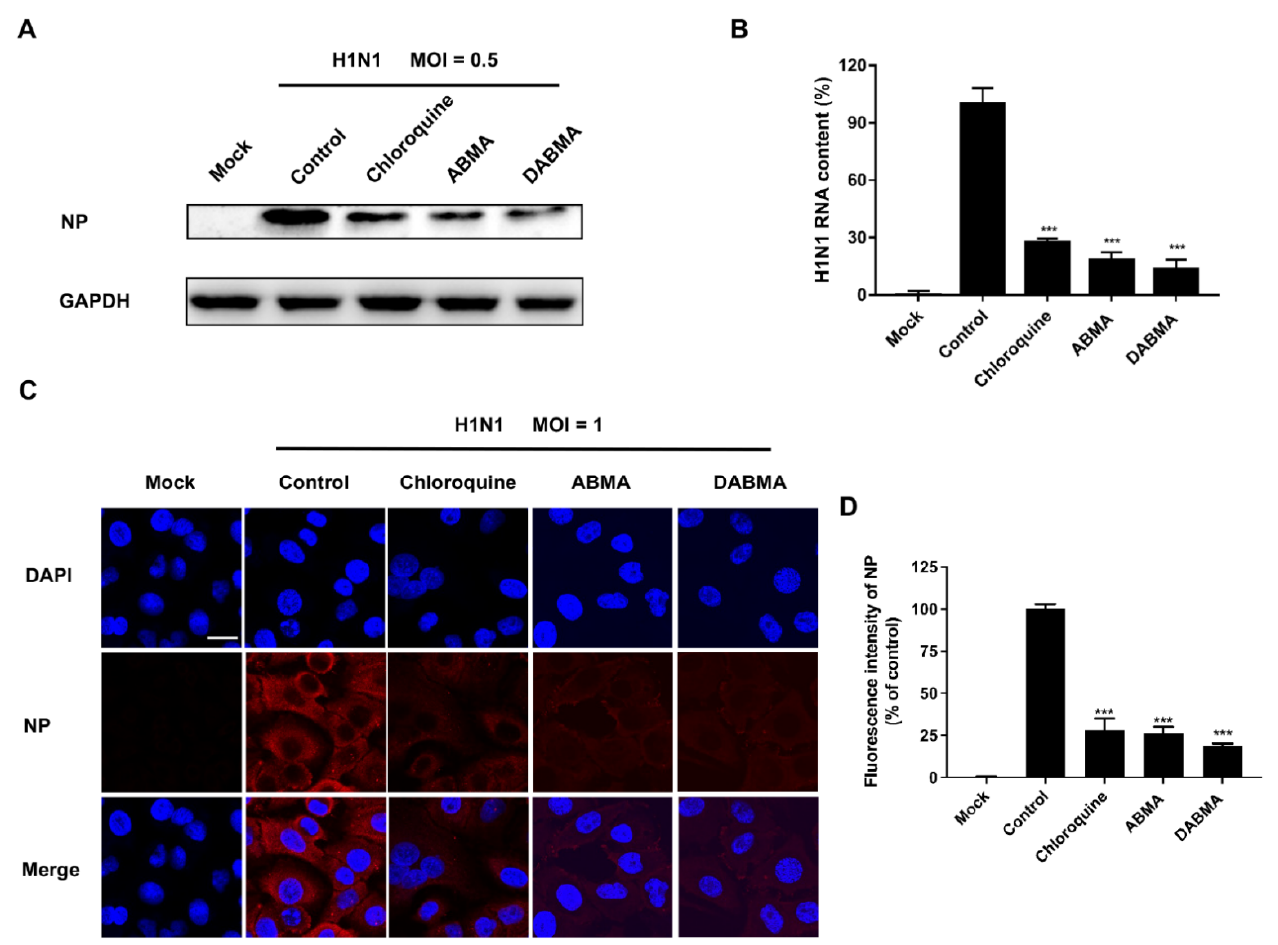
Figure 2. Inhibitory effect of ABMA and DABMA on H1N1 protein synthesis and RNA replication in cell cultures. MDCK cells were pretreated with ABMA or DABMA at 15 µM for 5 h and infected with A/NY/61/LV16A (H1N1, MOI = 0.5) for 1 h at 37 °C. Compounds were maintained until the end of the assay. Chloroquine (15 µM) was used as a positive control. ( A ) Nucleoprotein (NP) was detected by Western blotting using an anti-H1N1 NP antibody and an anti-GAPDH antibody was used as a loading control. ( B ) Relative viral RNA contents were measured by qRT-PCR using glyceraldehyde-3-phosphate dehydrogenase (GAPDH; Proteintech, 60004-1-Ig, Wuhan, China) as an internal control. ( C ) A549 cells were pretreated with ABMA, DABMA, or chloroquine at 15 µM for 5 h. At 16 h post infection with H1N1 (MOI = 1), cells were fixed in 4% paraformaldehyde and incubated with the primary antibody (anti-H1N1 NP, 1:100) overnight at 4 °C and incubated with the Cy5-conjugated goat anti-mouse (red) secondary antibody for 1 h at room temperature. The nuclei were stained with 4',6-diamidino-2-phenylindole (DAPI; blue). Scale bar: 20 µm. ( D ) Quantitative measurements of fluorescence intensity of NP were evaluated using the Image J software (Version 1.4, National Institutes of Health, Bethesda, MD, USA). Data represent mean ± SEM ( n = 3). Statistical significance was determined with one way ANOVA. Significance: *** p < 0.001 compared with virus control.